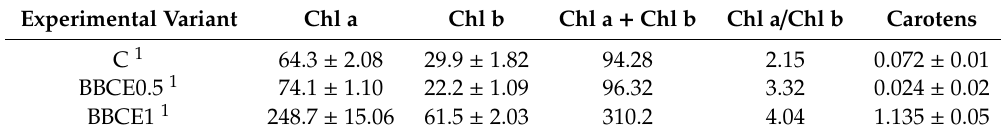
Table 2. Content of photo-assimilating pigments synthesized (µg/g) in sage leaves. Experimental